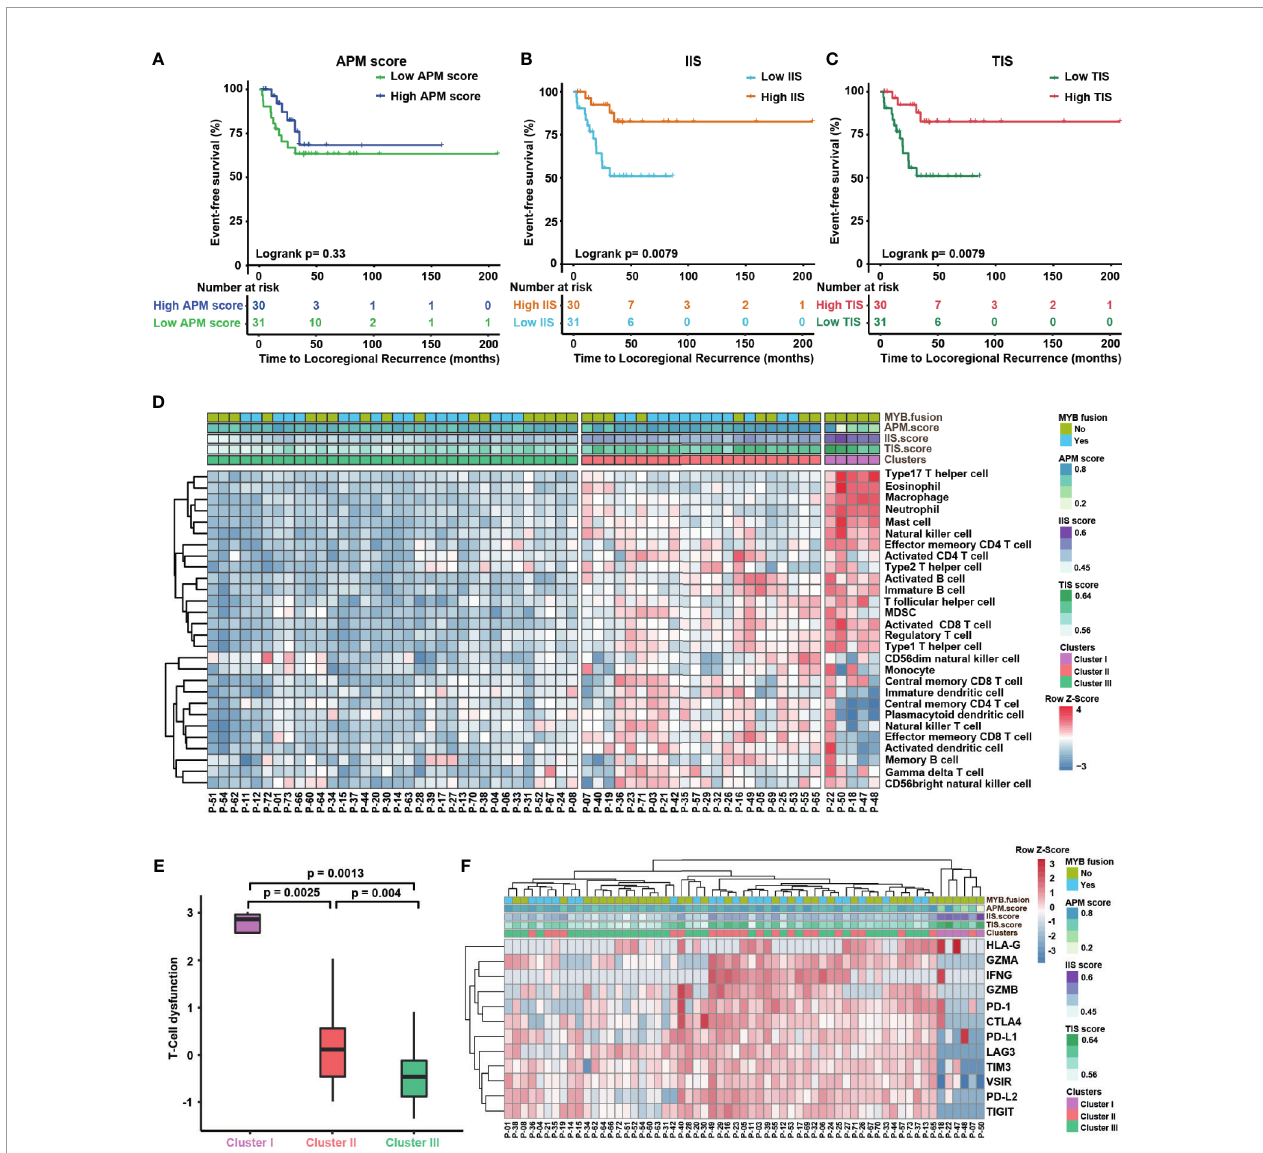
FIGURE 4 | Immune in fi ltration of tumor microenvironment may be able to exert an indicator of primary tumor recurrence. (A – C) Kaplan – Meier curves for distant metastasis-free survival in the above-median and below-median groups for the APM score (A) , IIS (B) , and TIS (C) . The median values for IIS and TIS are able to stratify 65 primary cases into groups with signi fi cant locoregional recurrence differences. Statistical signi fi cance was assessed by using the log-rank test. (D) Unsupervised hierarchical clustering of ACC patients from 65 primary tumors using ssGSEA scores from 28 immune cell types. Hierarchical clustering was performed with Euclidean distance and Ward linkage. We discover three immune in fi ltration clusters, here termed (1) cluster I (2), cluster II, and (3) cluster III. (E) TIDE was used to analyze T-cell dysfunction among three clusters. Kruskal – Wallis test with Dunn correction (nonparametric). (F) Heat map showing expression of the inhibitory checkpoint molecules (PDCD1, PD-L1, PD-L2, LAG3, TIM3, CTLA-4, TIGIT, and VISTA) and effector molecules prominently associated with T-cell response (GZMA, GZMB, HLA-G and IFNG) across tumors from 65 primary